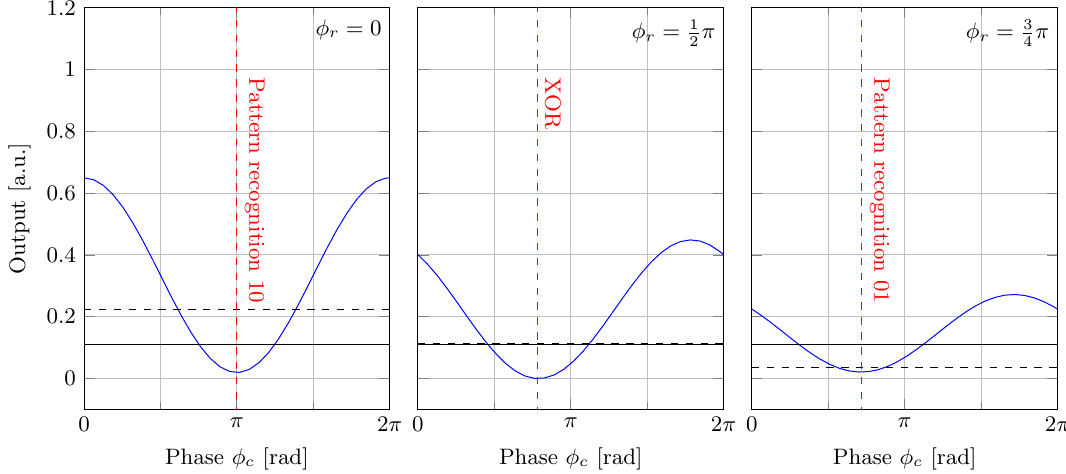
Figure 2. The perceptron prediction for several input states as a function of the common phase φ c between inputs u 1 and u 2 , u 3 for three values of the relative phase φ r between u 2 and u 3 . Red dashed lines indicate the optimal common phase required to solve the particular task indicated on the lines. The values of { u 1 , u 2 , u 3 } are respectively: 1, 1, 1 (blue line), 1, 0, 0 (continuous horizontal line), and 0, 1, 1 (dashed horizontal